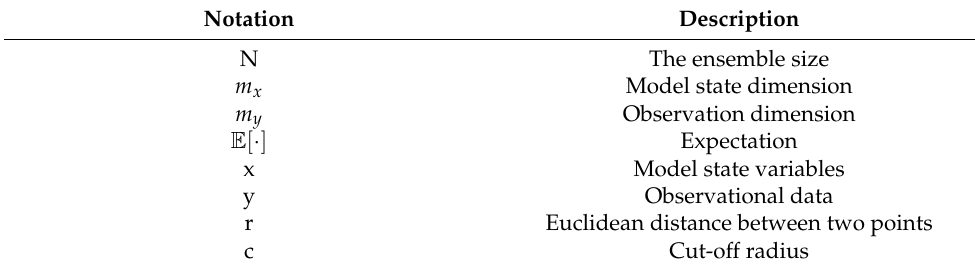
Table 1. Glossary of each